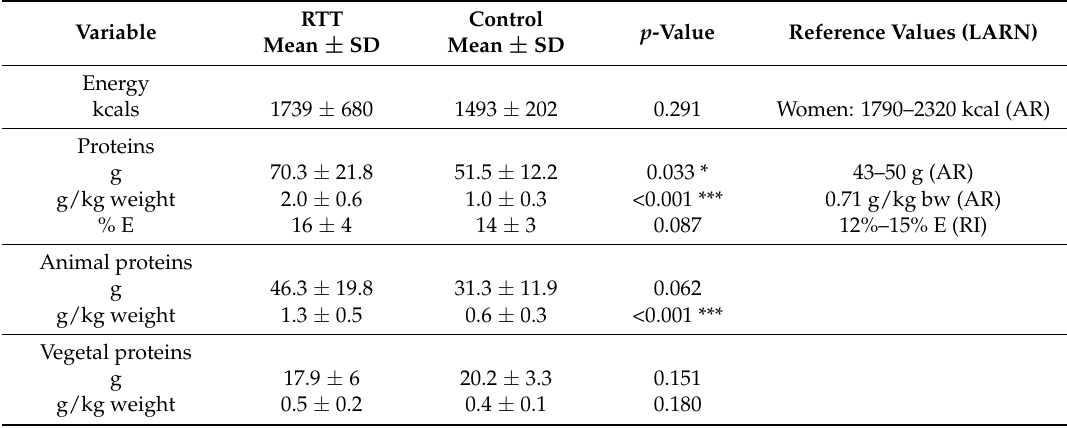
Table 2. Daily macronutrient intake in RTT and control (CTR)